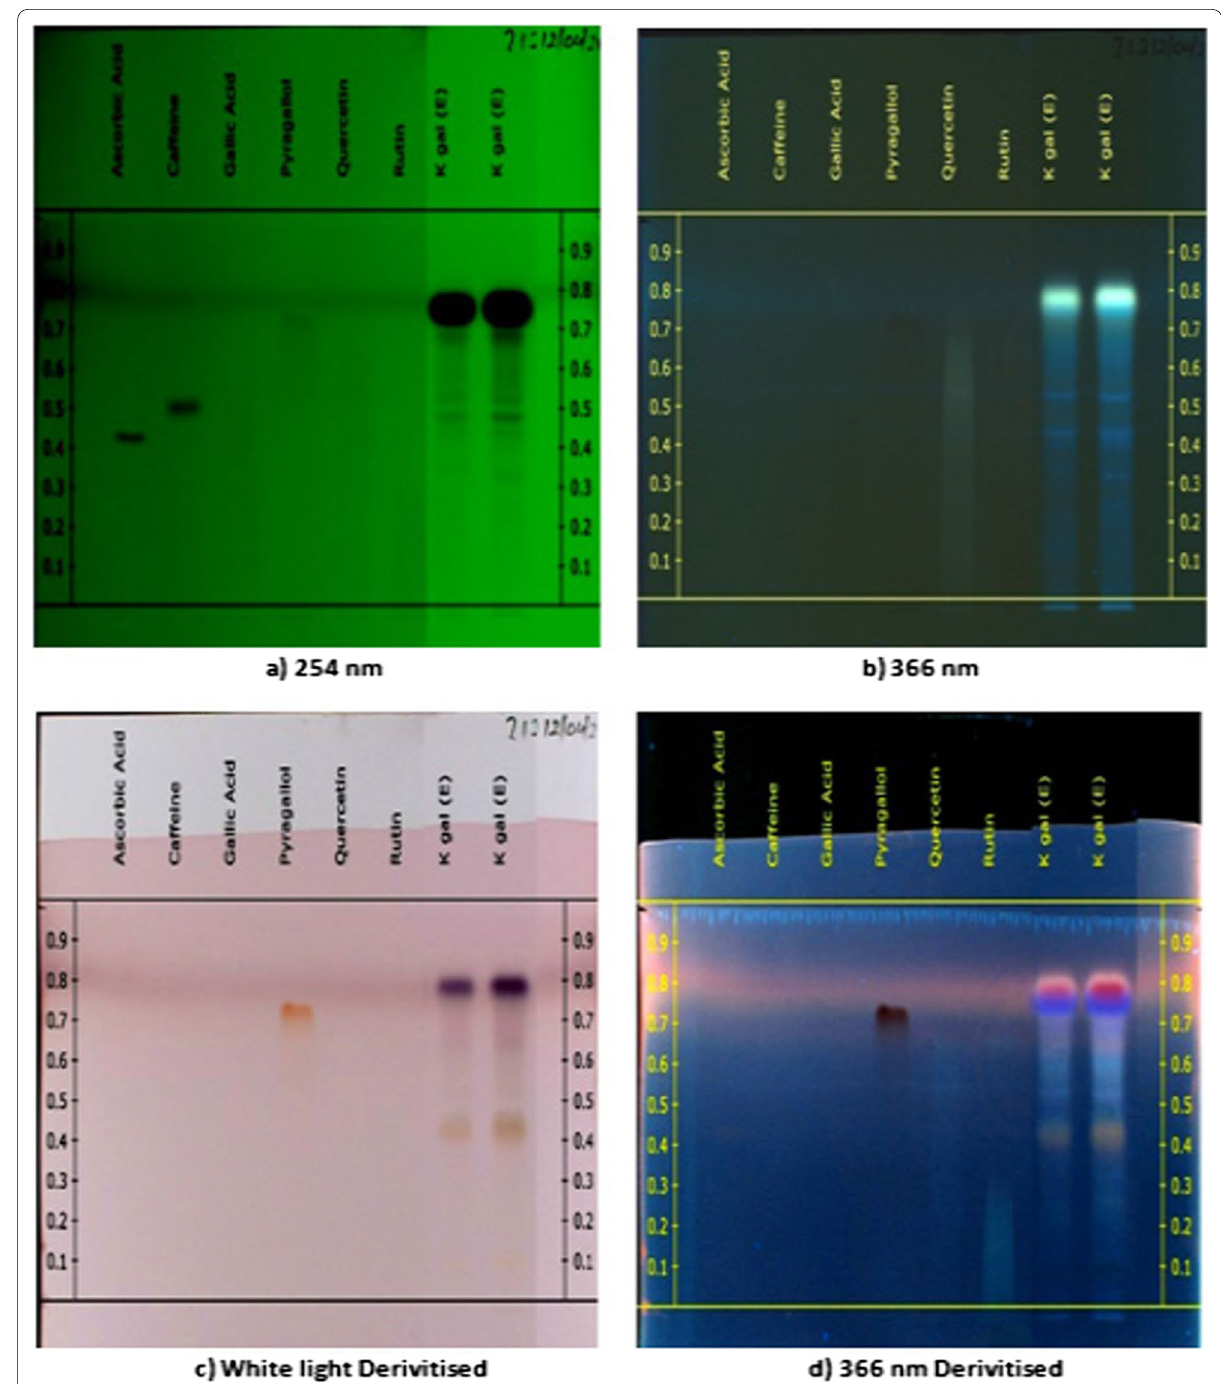
Fig. 3 HPTLC band chromatogram of the ethanolic extract of K.